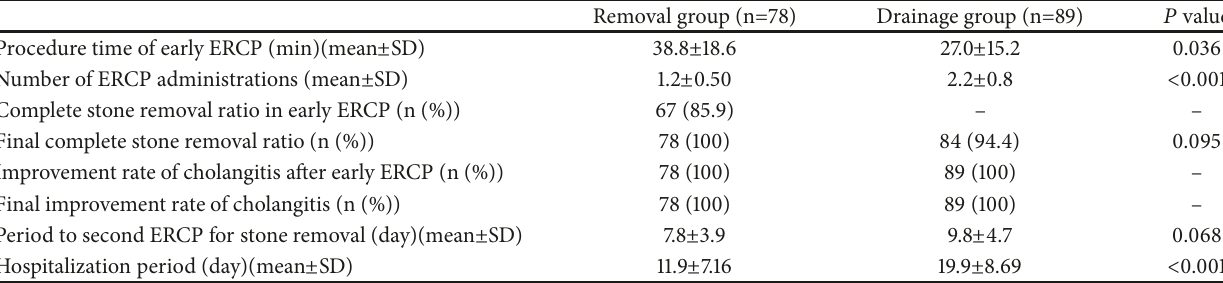
Table 3: Comparison of the treatment results between the removal and drainage groups.